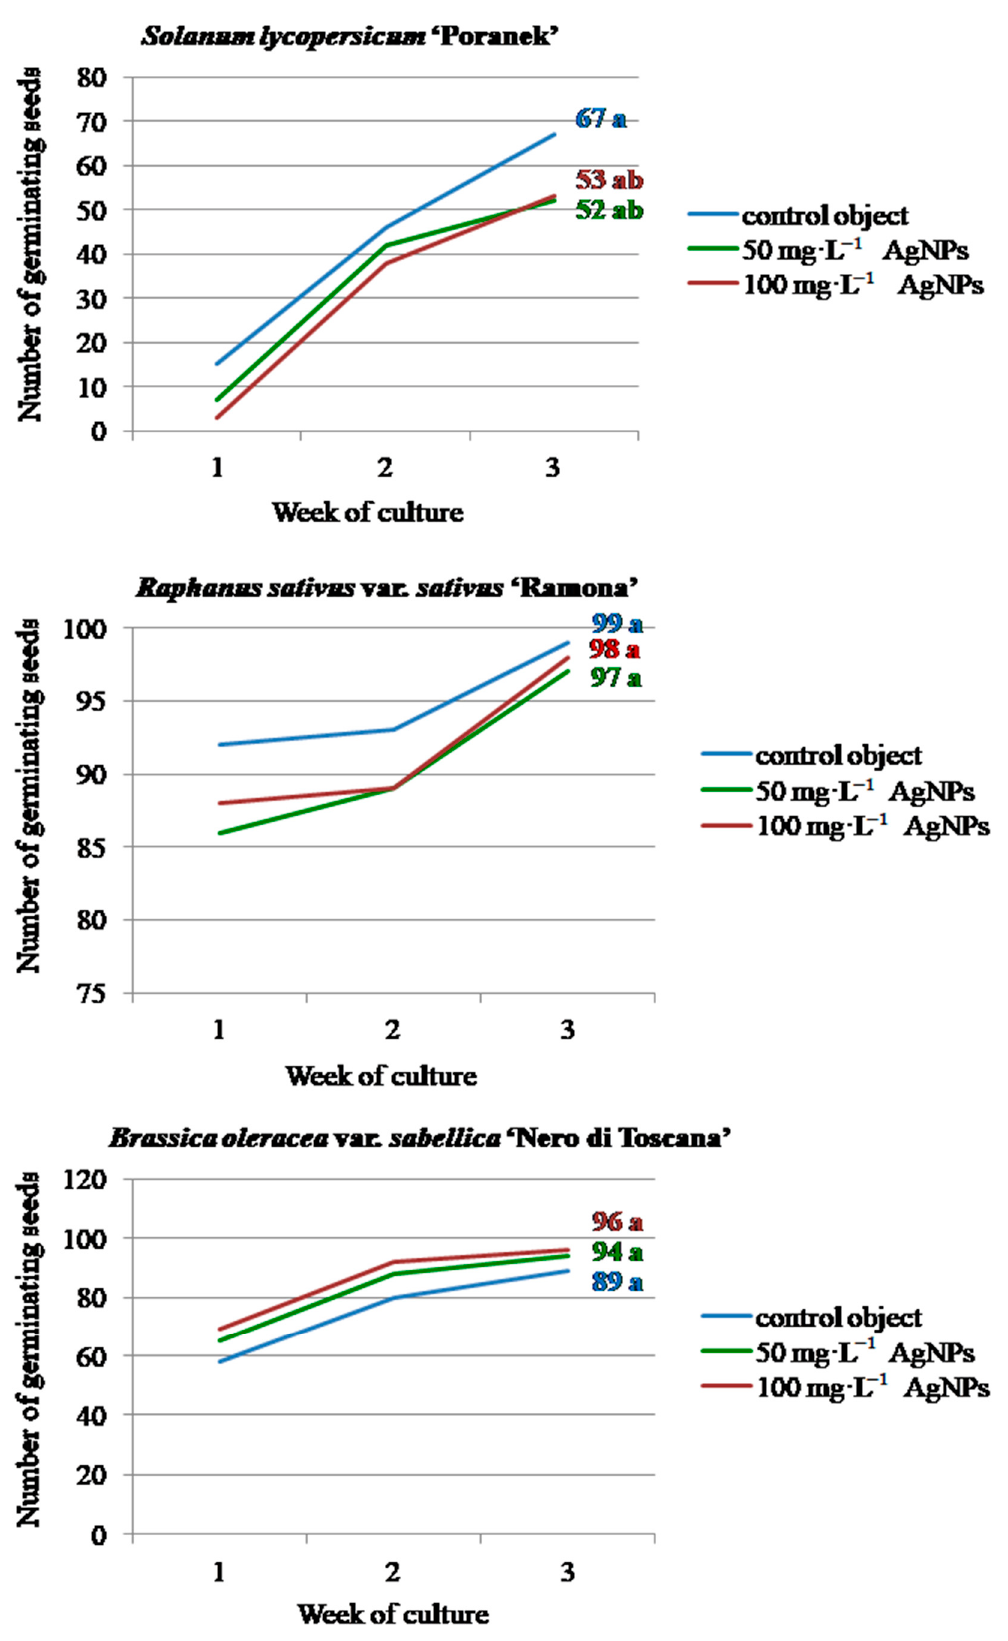
Figure 2. Dynamics and efficiency of in vitro seed germination in the tested vegetable plant species on the modified MS medium depending on the AgNPs